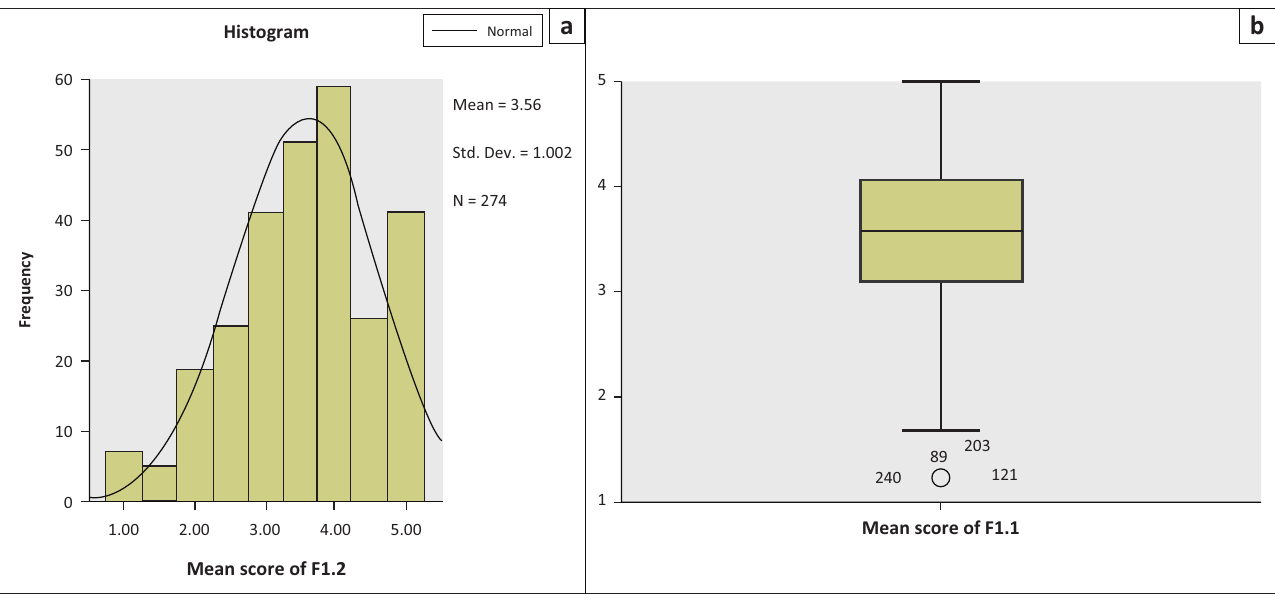
FIGURE 1: The histogram(a) and box plot (b) of the items in ‘The school’s motivation of learner performance in the Foundation